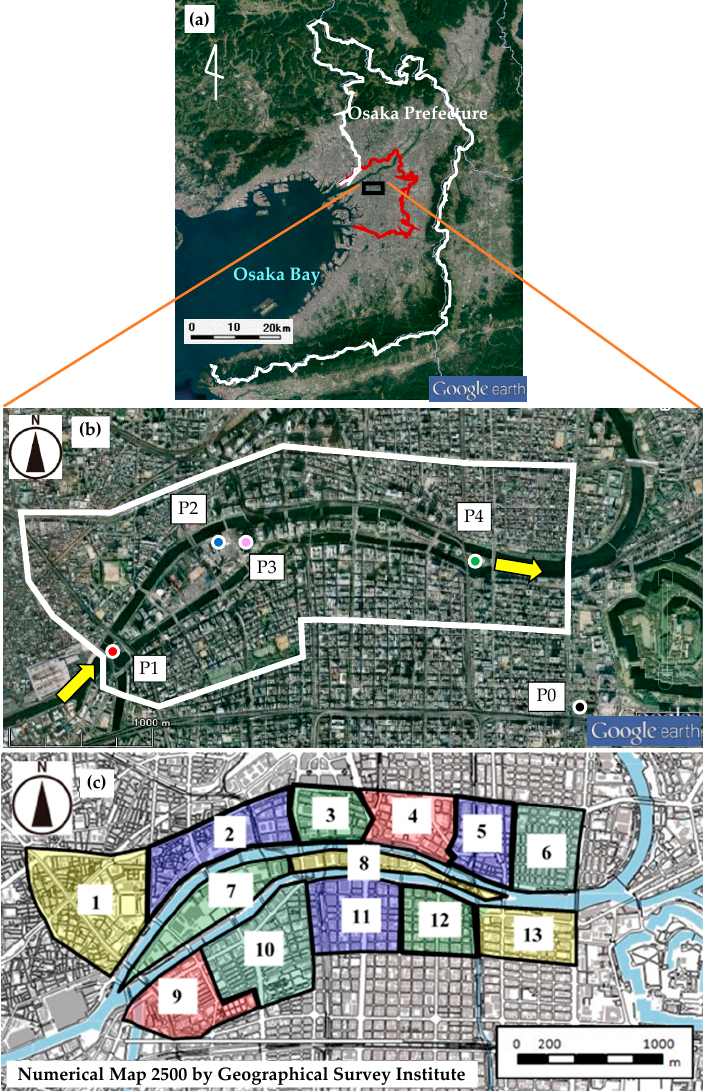
Figure 1. Maps of the study area; ( a ) Geographical feature of Osaka area. A white line and a dark-red line are the borders of Osaka Prefecture and Osaka City, respectively. ( b ) Study area (enclosed by the white line) and stationary observation points. Stationary observation of air temperature, relative humidity, and wind at ground level were executed at P2. The same elements were observed at P0 by the Osaka Meteorological Observatory and at P1 and P4 by The General Environmental Technos Co., LTD. Upper winds were observed at P2 using pilot balloons. Surface temperature on the rivers were observed from a building at P3. Yellow arrows indicate mean wind directions in the daytime at P1 and P4, respectively. ( c ) Subareas for mobile observations (13 divisions. 28 July. and 31 August., 2010). Serial number in the figure indicates the ID of each subarea. Area of the Nakanoshima district corresponds to subarea 7 and